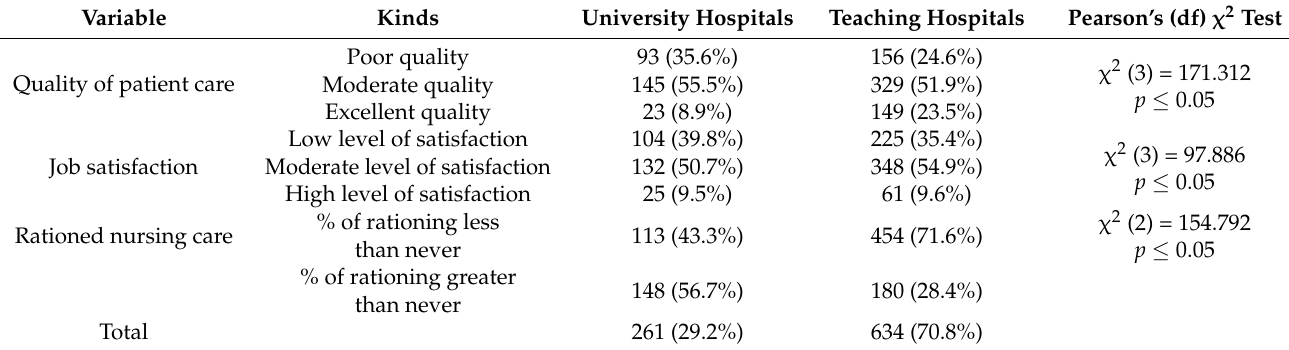
Table 4. Comparison of rationed nursing care across the hospital